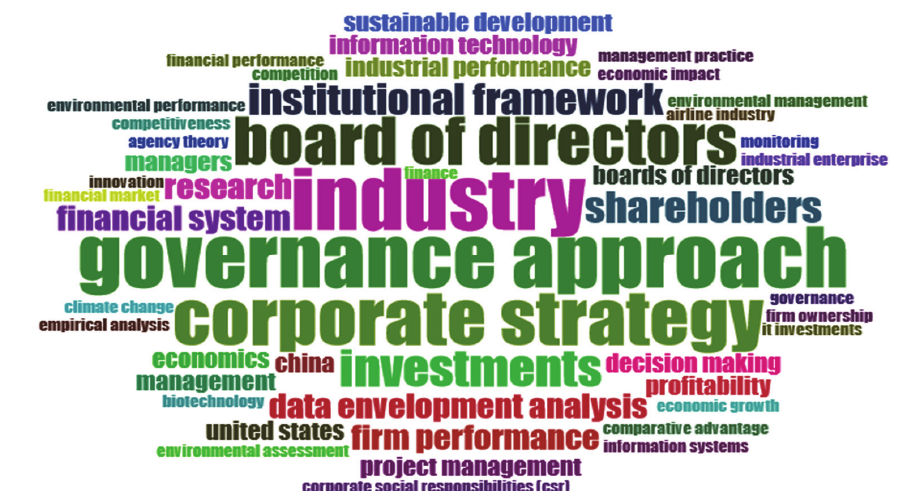
Fig. 7. The frequency of the keywords used in different corporate governance